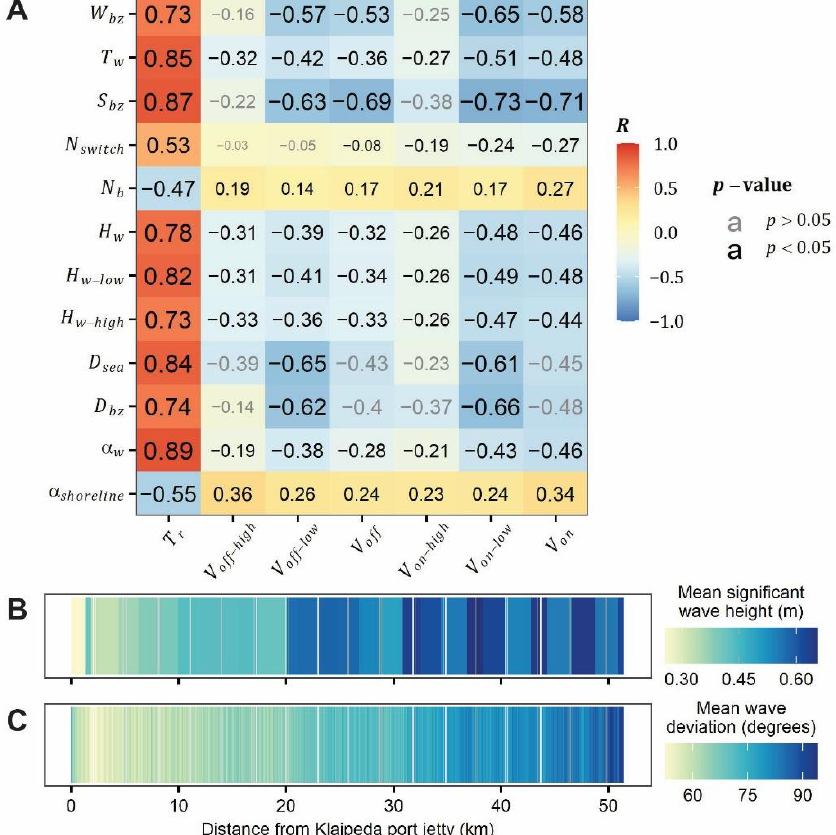
Figure 12. The relationship between temporal bar characteristics and environmental variables ( A ). Numbers in black indicate statistically significant correlation rates (with 95% confidence), and numbers in grey indicate statistically insignificant rates. The size of the number shows the magnitude of the correlation. Panels ( B , C ) display alongshore variability in the mean significant wave height ( B ) and the mean deviation of wave direction from the shore-normal angle ( C ) in the Curonian Spit in 2011 – 2021.